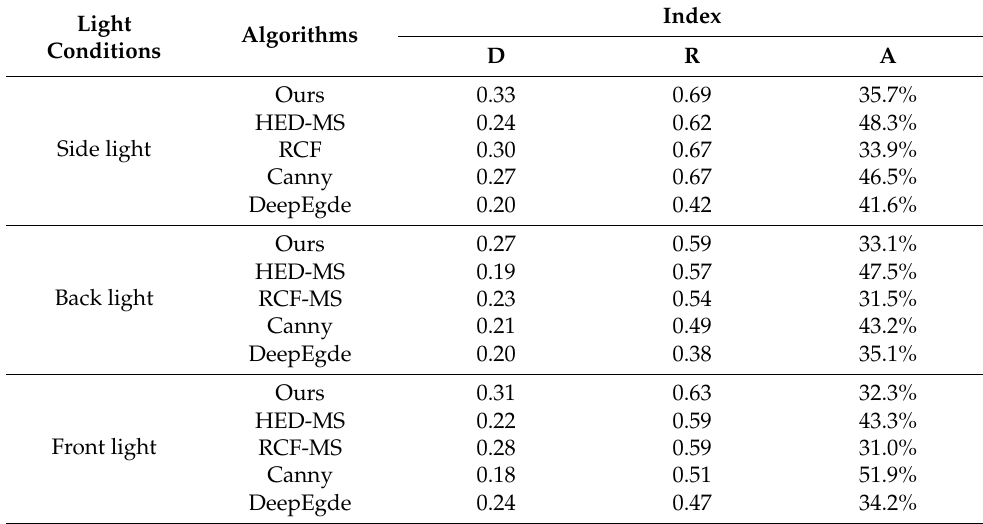
Table 2. Experimental results of five algorithms on grapes under different light conditions.